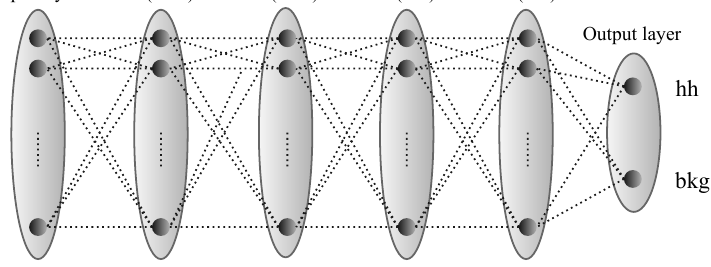
Figure 2 . A schematic architecture of the fully-connected NN (FC or DNN) used in this